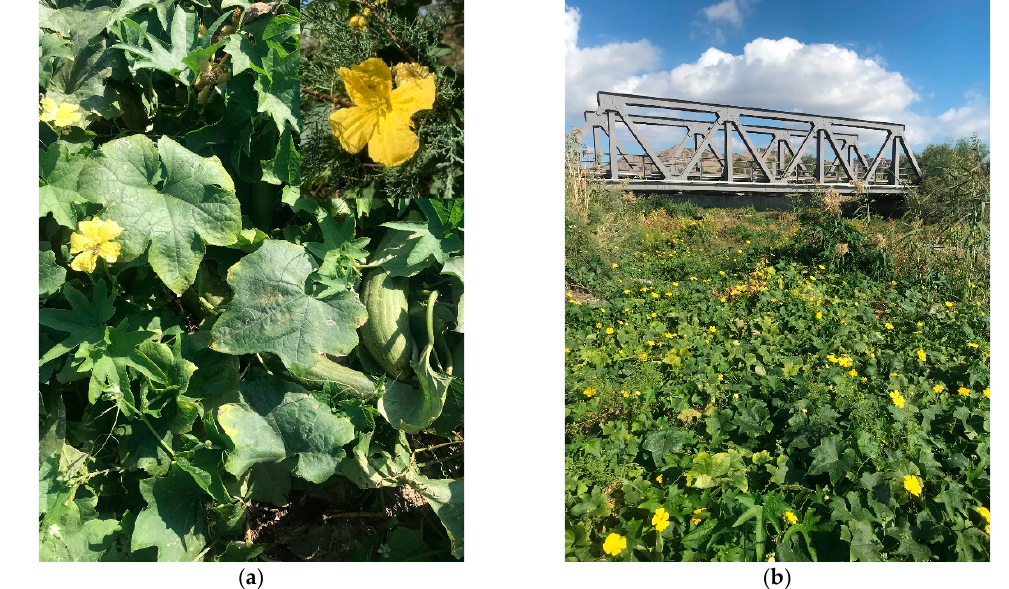
Figure A8. Luffa aegyptiaca Mill. in Fiumara Acrifa (Reggio Calabria province). ( a ) Immature fruits, leaves, and flowers; ( b ) several plants along the riverbed of the fiumara (Photographs VLA Laface).